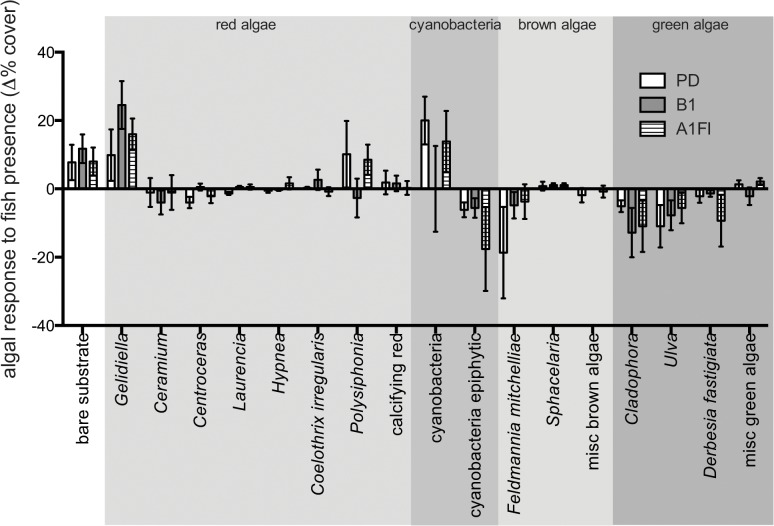
Percent cover of algae.The percent cover of algae in the presence minus the percent cover of algae in the absence of fish (mean ± SE), highlighting the impact of fish on algal turfs under present-day conditions (PD or present-day = open bars) and two CO2 emissions scenarios (B1 or “reduced” CO2 emission scenario = grey and A1FI or “business-as-usual” CO2 emission scenario = stripes). Only algae with a cover > 1% were included.